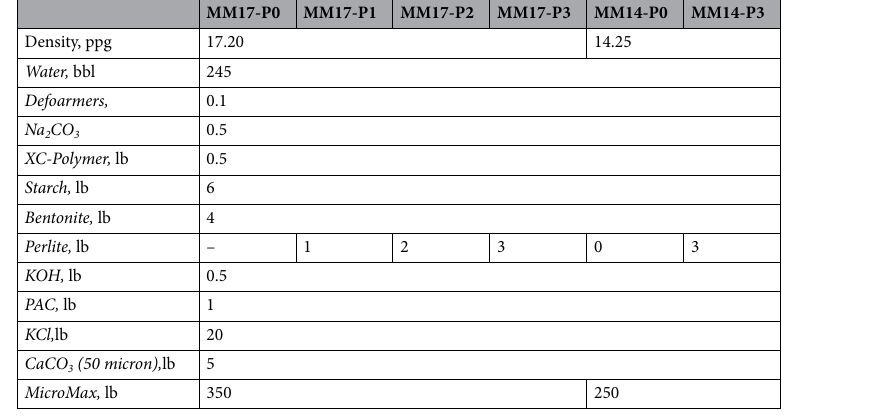
Table 2. Drilling fluid formulation.